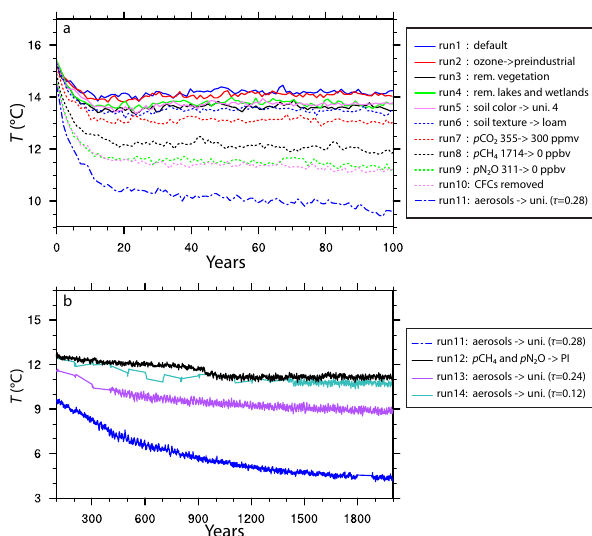
Fig. 2. Time series of annually averaged global mean surface tem- perature obtained for the test runs listed in Table 1. (a) and (b) show the short-term and extended runs, respectively. For part of the long runs 11, 13 and 14, only 10 yr of results were retained for every 100yr period and these segments have been connected by straight lines in order to create continuous curve shown. Note that the leg- ends describe only the further change of parameters relative to the previous